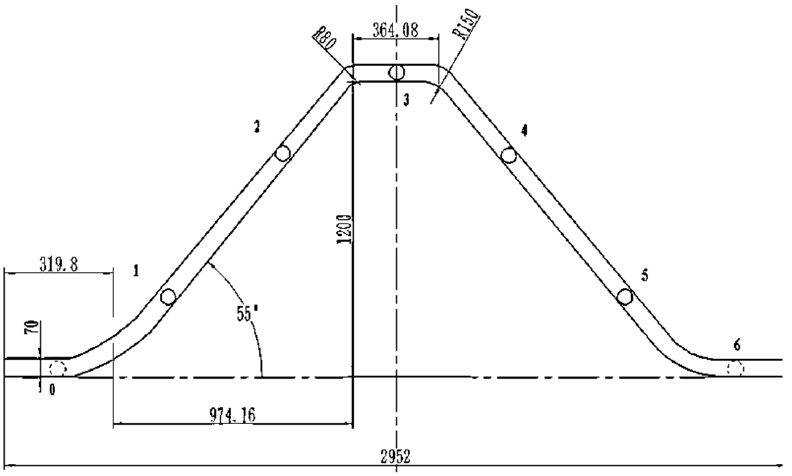
Figure 10. Influence of the relative motion of the roller on the device motion. Note: 1—positive acceleration critical point, 2—critical point of forwarding deceleration, 3—main roller in uniform speed stage (launch stroke), 4—reverse acceleration critical point, 5—reverse deceleration critical point, 6—(left) bomb position, (right) shell position.